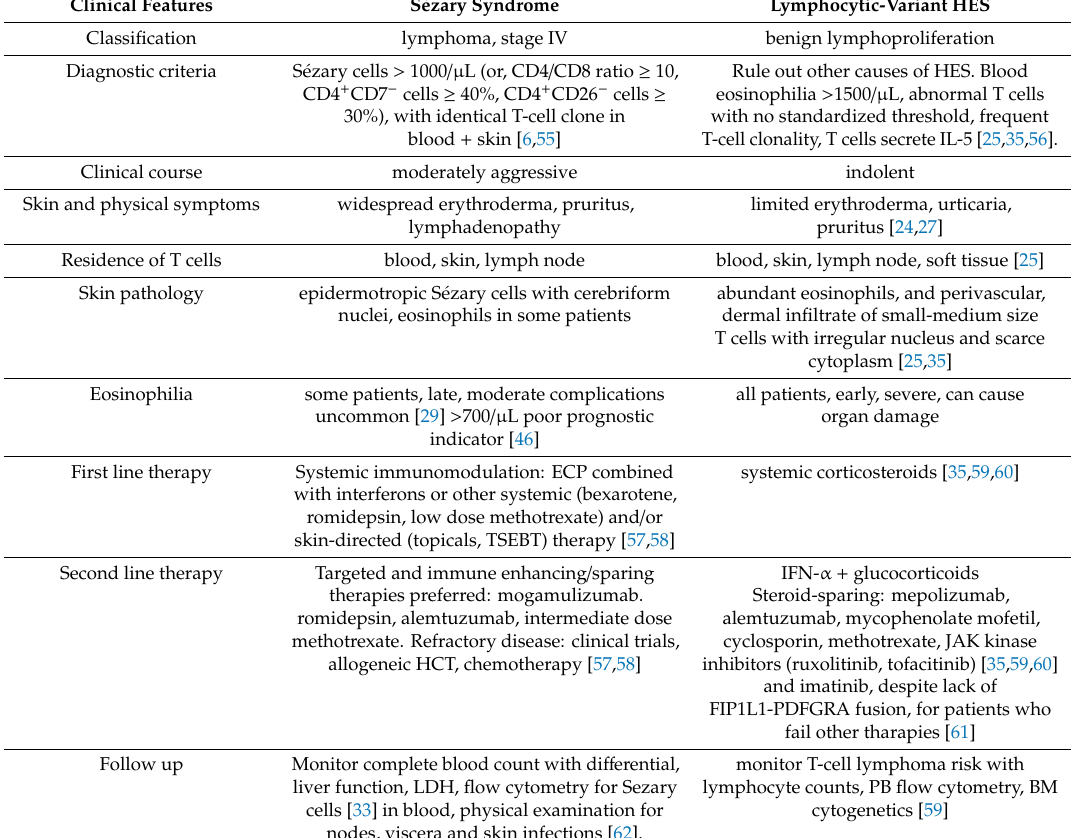
Table 2. Clinical and molecular features of S é zary syndrome and lymphocytic-variant hypereosinophilic syndrome